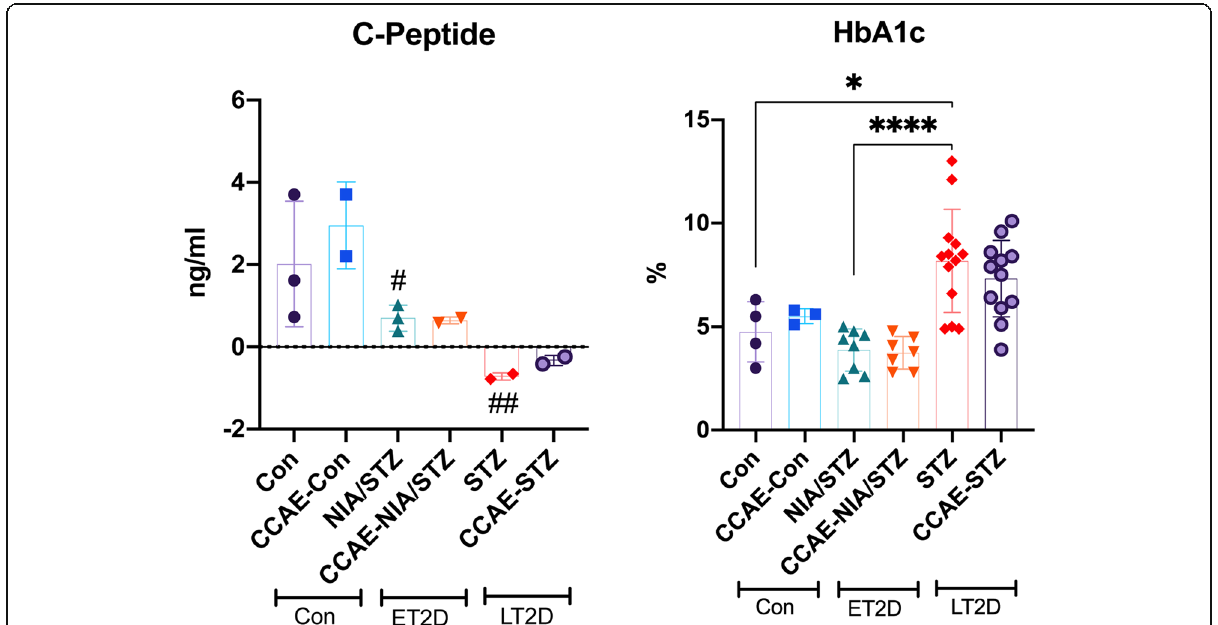
Fig. 3 C-peptide and HbA1c levels on day 28. C-peptide levels indicate total or partial destruction of pancreatic β -cells in STZ- and NIA/STZ- rat groups, respectively, and that treatment with CCAE for 28 days did not increase insulin secretion remaining β -cells. HbA1C levels increased in diabetic groups; 28 days of treatment with CCAE did not produce any change in HbA1C levels of treated diabetic groups relative to untreated counterparts. Con: nondiabetic control, CCAE-Con: nondiabetic control treated with CCAE, NIA/STZ: early-stage diabetic group, CCAE-NIA/STZ: the early-stage diabetic group treated with CCAE, STZ: late-stage diabetic group, CCAE-STZ: the late-stage diabetic group treated with CCAE. *, p < 0.05; † , p = 0.001. #, p < 0.05 and ##, p < 0.01 show significant differences between the diabetic group (STZ or NIA/STZ, respectively) versus Con